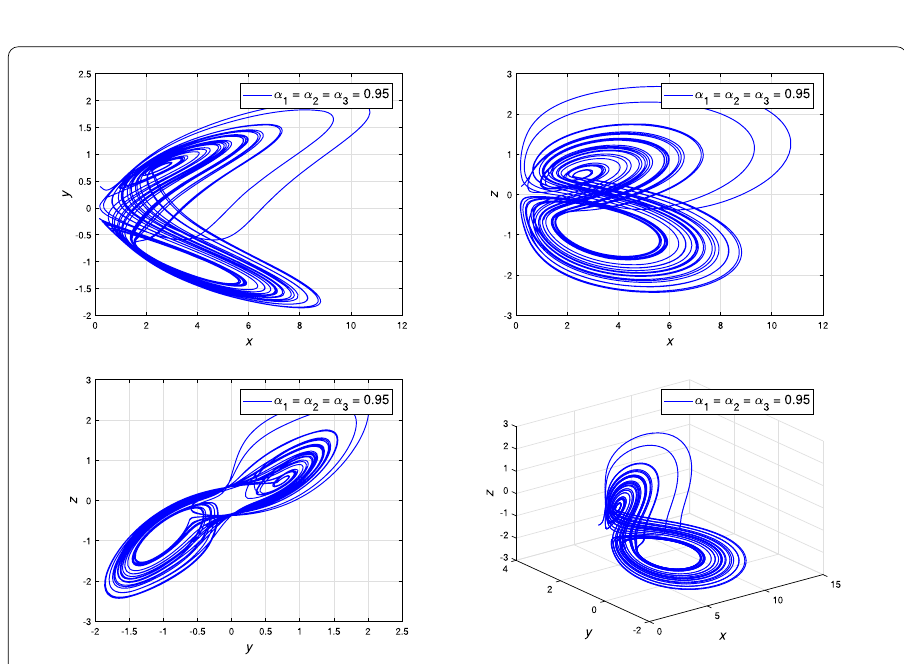
Figure 6 State variables of the fractional-order model (21) in the phase-plane ( α i = 0.95, i =